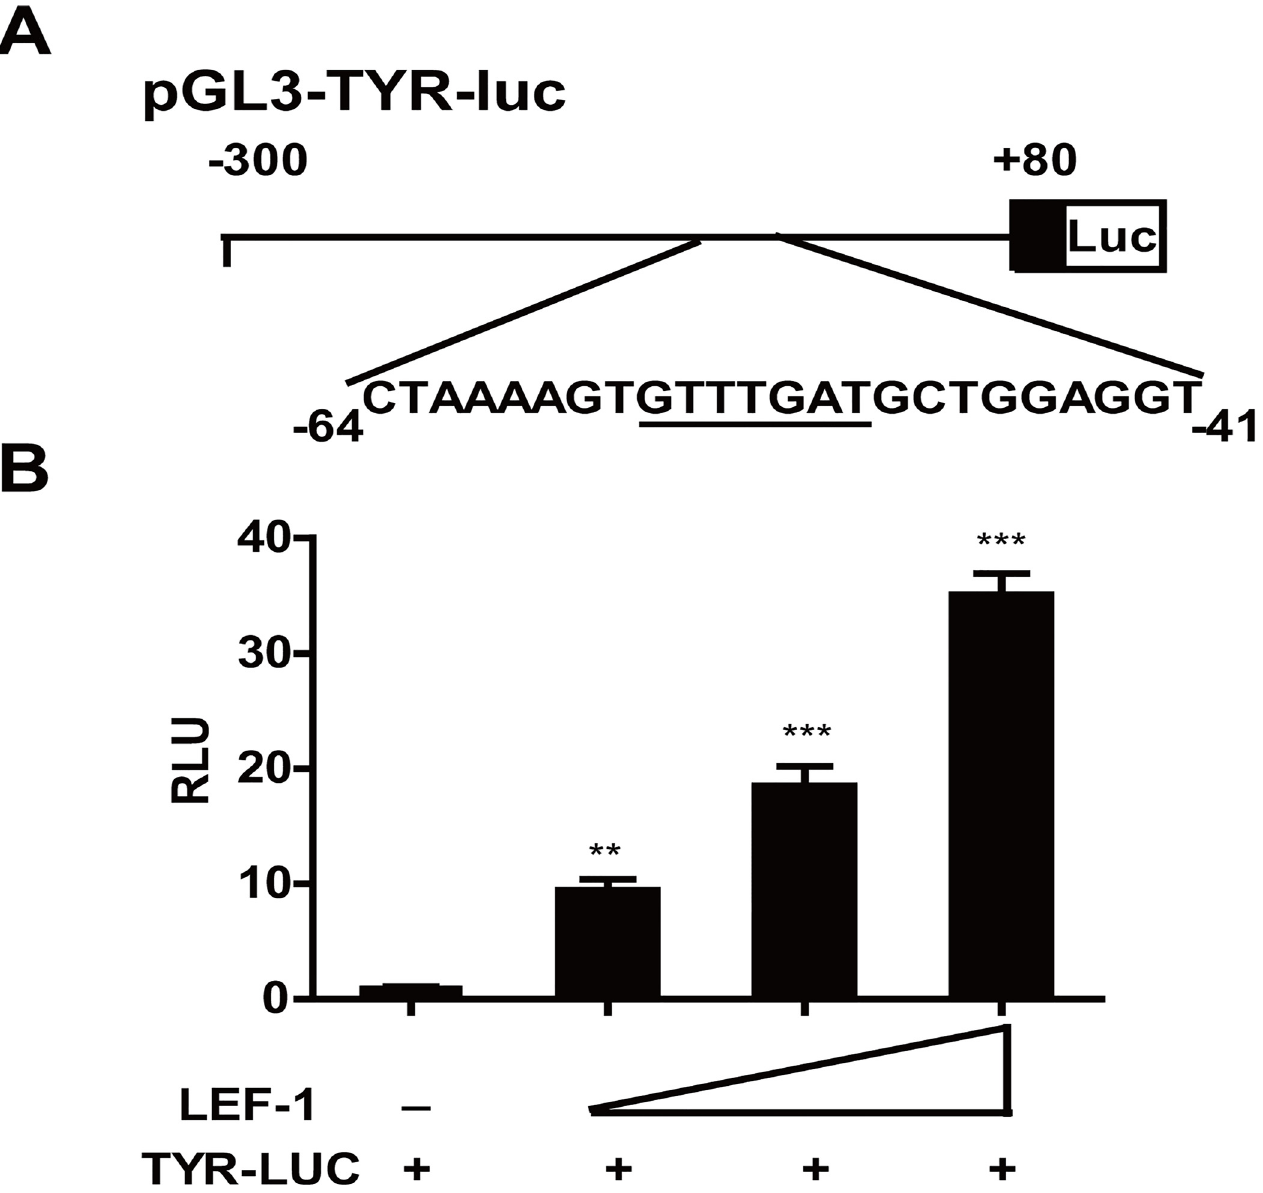
Fig 2. TYR is a direct LEF-1 target gene. A Schematic representation of the human TYR promoter sequence containing 380 bp (-300 bp to +80 bp) together with the potential LEF-1 binding sites (double underlined) and their flanking sequences. B TYR transcriptional activity determined by Luciferase activity assay. The TYR -Luc luciferase reporter plasmid was transiently transfected into melanoma UACC903 cells in combination with increasing amounts of LEF-1 expression vector. The basal luciferase level was set to 1. Data from all other transfections are presented as fold induction above this level. Luciferase activity was normalized by measuring β -galactosidase activity. Each value represents the mean ± SD of three replicates from a single assay. The results shown were representative of at least three independent experiments. ( ** p < 0.01, *** p < 0.001 compared to basal activity, unpaired Student ’ s